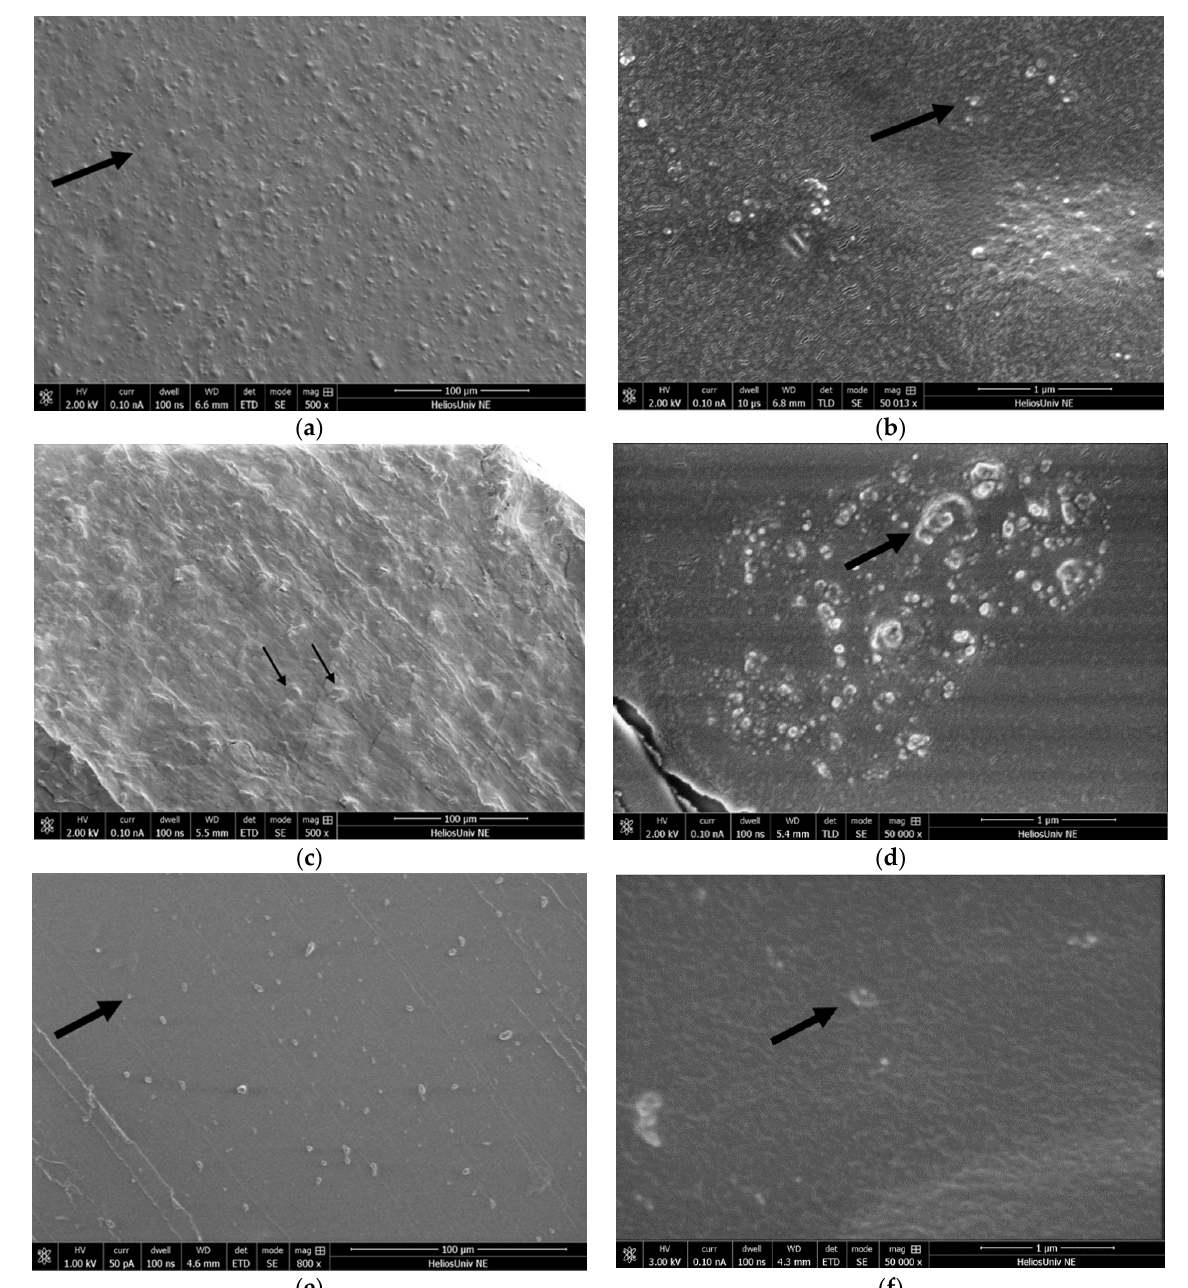
Figure 3. ( a ) Dispersion of 15% KH220 filler loading at 500× magnification. Nanoparticles appear to be evenly distributed into the polymer. Arrow indicates a nanoparticle. ( b ) Dispersion of 15% KH220 filler loading at 50,000× magnification. Arrow points to a nanofiller particle approximately 20 nm diameter. ( c ) Dispersion of 15% Uncoated Filler loading at 500× magnification. Arrows indi- cate agglomeration of nanoparticles. A large number of aggregates can be seen throughout the pol- ymer. ( d ) Dispersion of 15% Uncoated Filler loading at 50,000× magnification. Image demonstrates up to 0.4 μ m diameter agglomerated nanoparticles (arrow), which are approximately 20 times larger than nanoparticles observed in Figure 2b. ( e ) Dispersion of 15% TS530 filler loading at 800× magni- fication. Particles appear to be evenly distributed into the polymer, however, fewer particles are observed compared to nanofillers with similar magnifications. Arrow indicates submicron particle. ( f ) Dispersion of 15% TS530 filler loading at 50,000× magnification. Arrow points to filler particle approximately 200 nm in diameter.